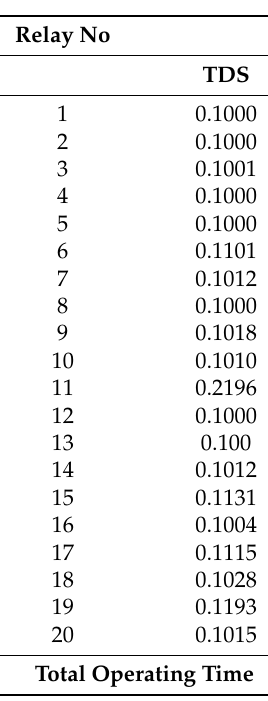
Table 8. Optimum TDS and PS for Case 3.